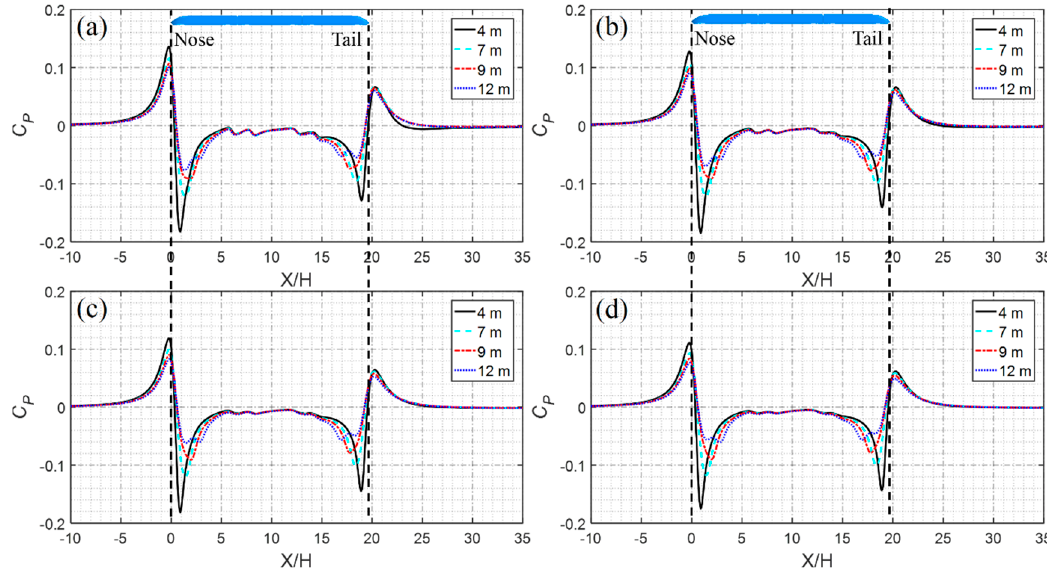
Figure 12. Definition of maximum pressure coefficient ( Δ Cp max), the absolute value of minimum pressure coefficient ( Δ Cp min), and pressure change coefficient ( Δ Cp ).